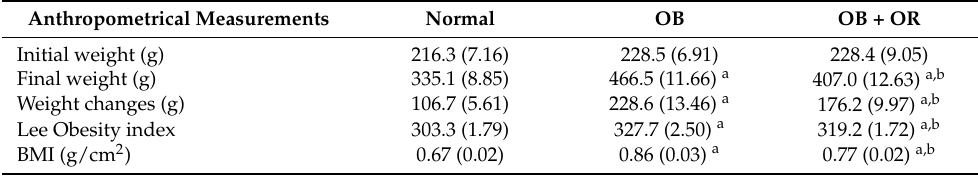
Table 1. Effect of orlistat on anthropometrical measurement in obese rats.